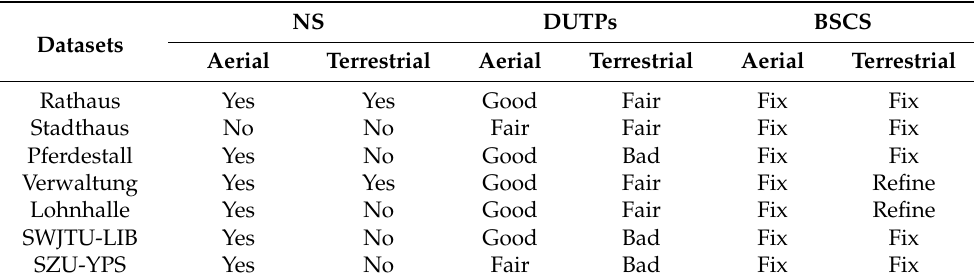
Table 12. Summary of the network stability (NS), distribution uniformity of tie points (DUTPs), and best self-calibration strategy (BSCS) in the BA of aerial–terrestrial images for the seven datasets.